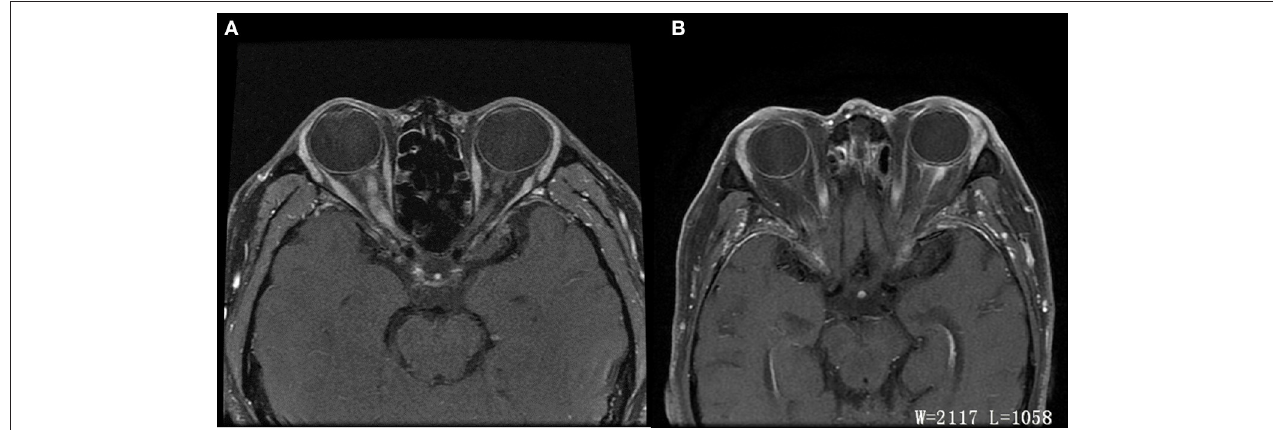
FIGURE 1 | Differences of ON and OPN in MRI. (A) ON: Axial T1 contrast image showed enhancement of right optic nerve. (B) OPN: Axial T1 contrast image showed enhancement of left optic sheath, not enhancement of optic nerve.